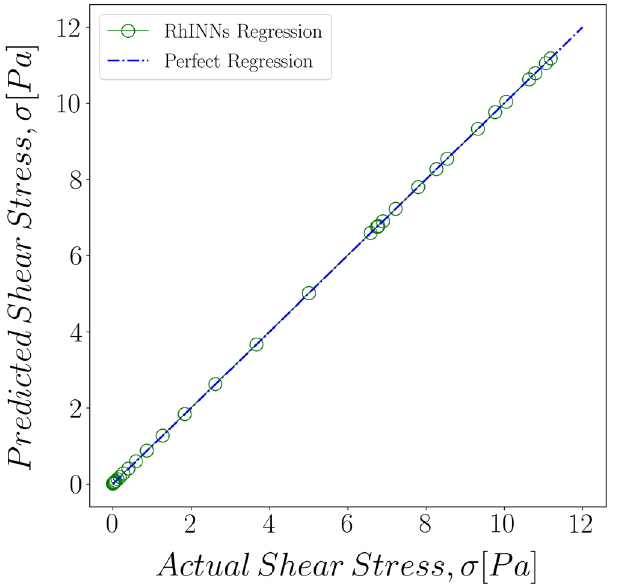
Figure 3. The regression between the ground solution and the predictions made by RhINNs for a direct problem based on a TEVP mode in start-up of flow with the shear rate of ˙ γ = 0.1 [ 1 / s ] .